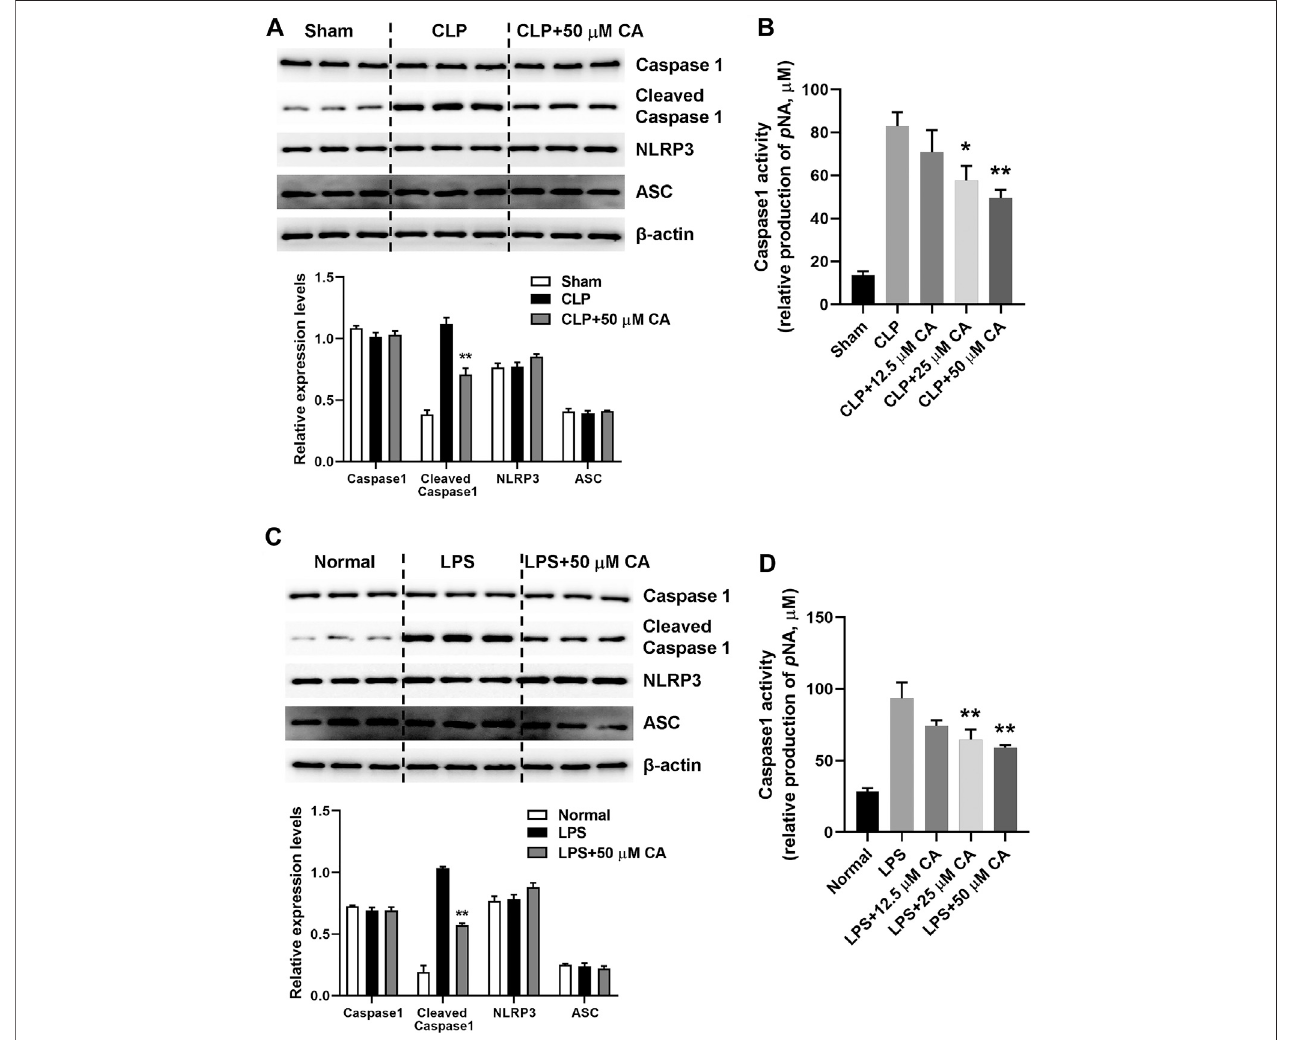
FIGURE4| Calycosin inhibitsNLRP3 in fl ammasome activationinlung tissue.Theligatedor LPS-injected miceweretreatedwithcalycosin bygavageat 0and 6 h. After 12 h, NLRP3 in fl ammasome associated protein levels in lung tissue were determined by western blot analysis. The quantitative densitometry of the protein expressions was determined by Image J software. Densitometric values were normalized to β -actin. The caspase 1 activity in lung tissue was determined by a commercial kit. Data are presented as means ± SEM. * p < 0.05; ** p < 0.01 vs. the CLP or LPS group.